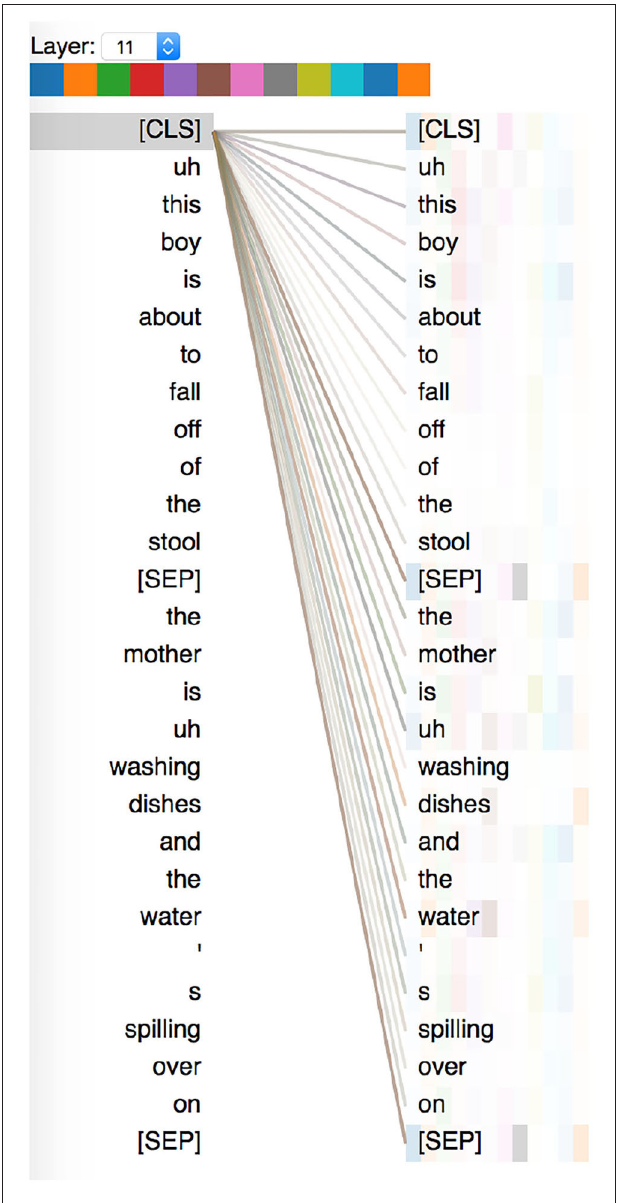
FIGURE 2 | An attention visualization plot showing attention contributions of embeddings corresponding to each word to the “pooled” representation. This example is a sub-sample (first two utterances) of a speech transcript from a healthy person.